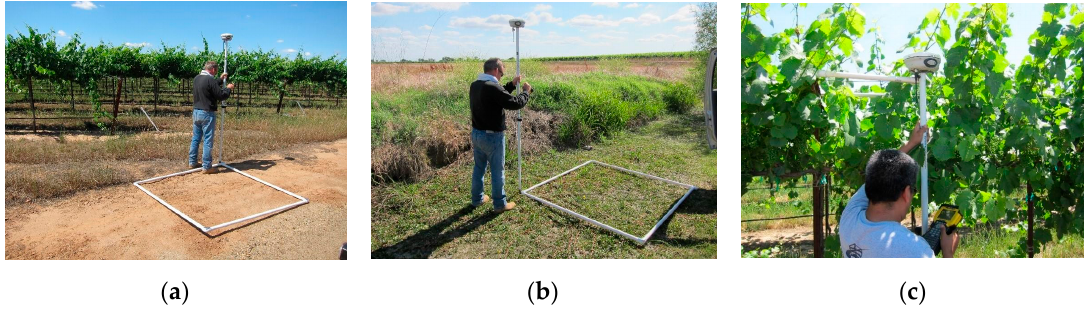
Figure 6. Examples of ground locations for temperature sampling the day before the sUAS flight shown in Figure 2. Locations were delimited using PVC and surveyed using RTK GPS. Note the diversity of locations: bare dry soil ( a ), short green canopy ( b ), and tall canopy ( c ).